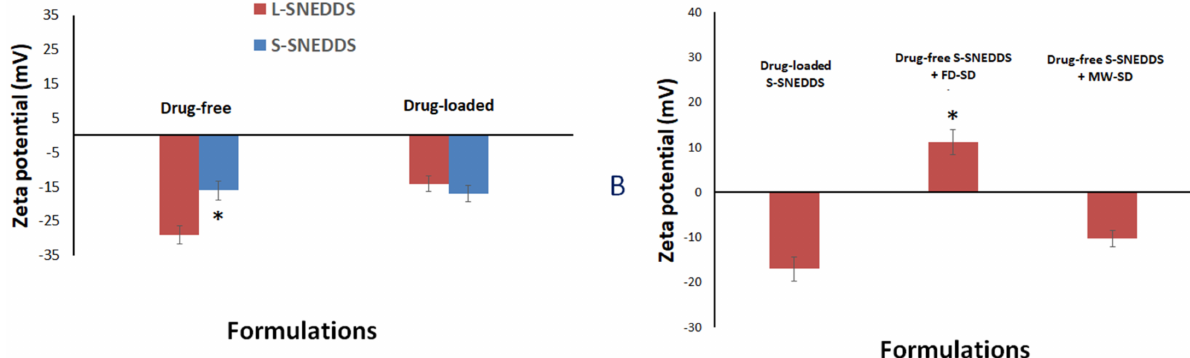
Figure 5. Influence of ( A ) drug-loading and ( B ) combined solid SNEDDS on formulation zeta potential. * denotes significant ( p < 0.05) difference from counterpart formulations. Data are expressed as mean ± SD, n =